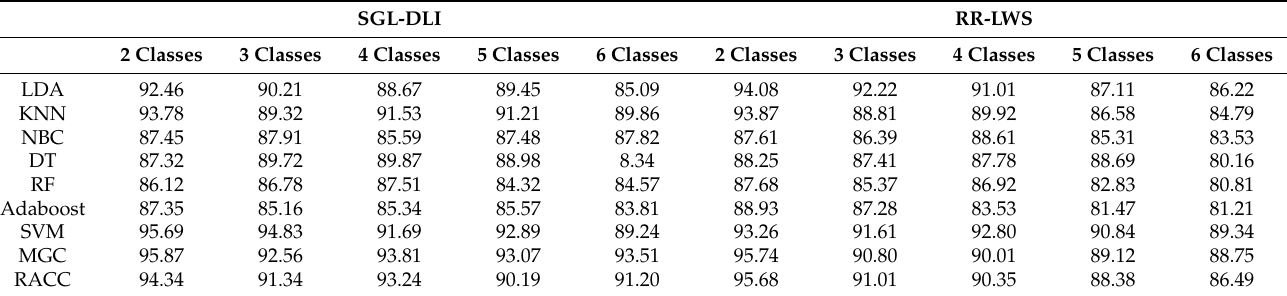
Table 3. Spectral clustering with SVD-based spectral algorithm.